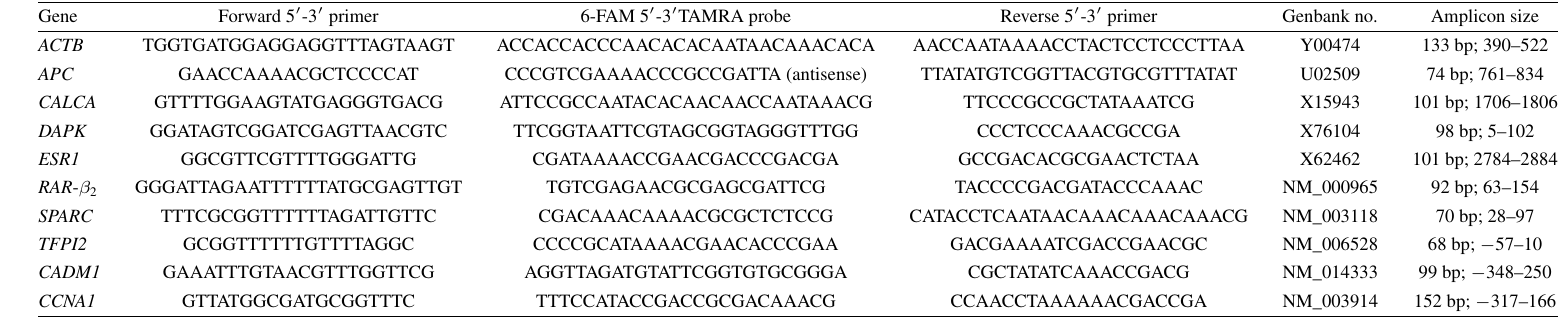
Primers and probe